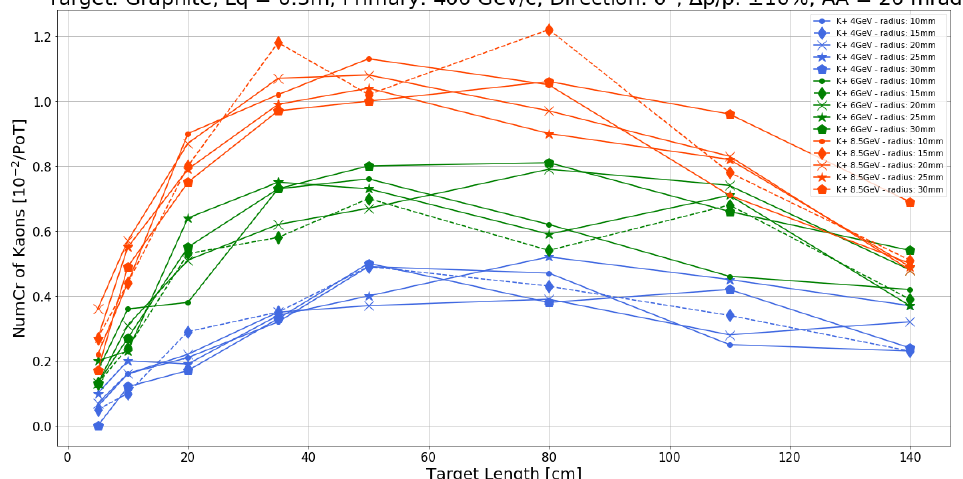
Figure 4. Kaon yields as a function of the graphite target length. The primary beam simulated is a 400 GeV/c proton beam. The figure of merit for this study is the number of kaons of given energy with 10% momentum bite that enters an ideal beamline with both planes, placed 30cm after the target (Lq). The error bars are not plotted to ease the reading; statistical errors are negligible (1%), while the Monte-Carlo systematics amounts to 5. Hadron